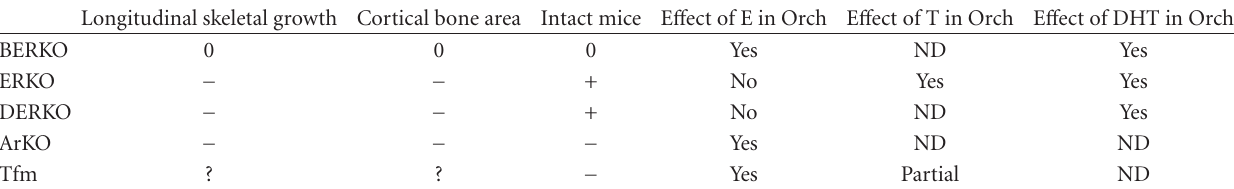
Cancellous bone